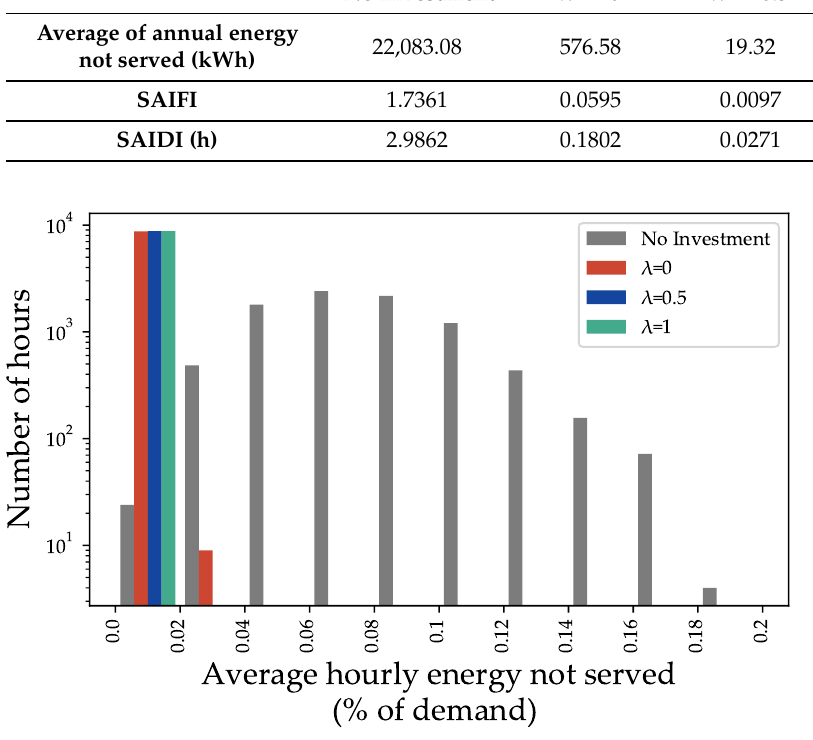
Figure 5. Out-of-sample analysis—Average hourly annual energy not